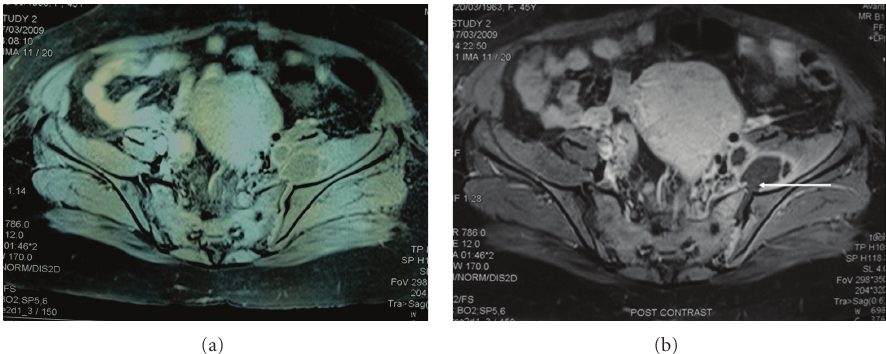
Figure 2: MRI of the pelvis and sacroiliac joints. Coronal T1-weighted (a) as well as (b) fat-saturated (FS) post IV contrast images of the pelvis and sacroiliac joints; showing a 5cm in diameter multiloculated collection showing dense marginal enhancement deep to left iliopsoas muscle communicating with underlying left sacroiliac joint cavity (see arrow) with evidence of left sacroiliitis in the form of irregular articular surface with subarticular thickening as well as enhancement.